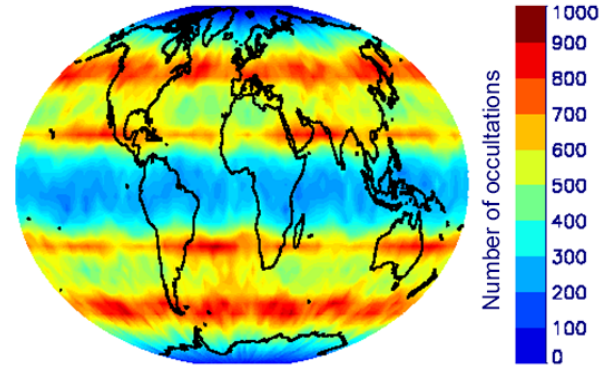
Figure 2. Global distribution of GPS radio occultation profiles pro- vided by the COSMIC satellites between 2014 and 2016. The num- ber of occultation refers to a 5 ◦ × 5 ◦ latitude–longitude